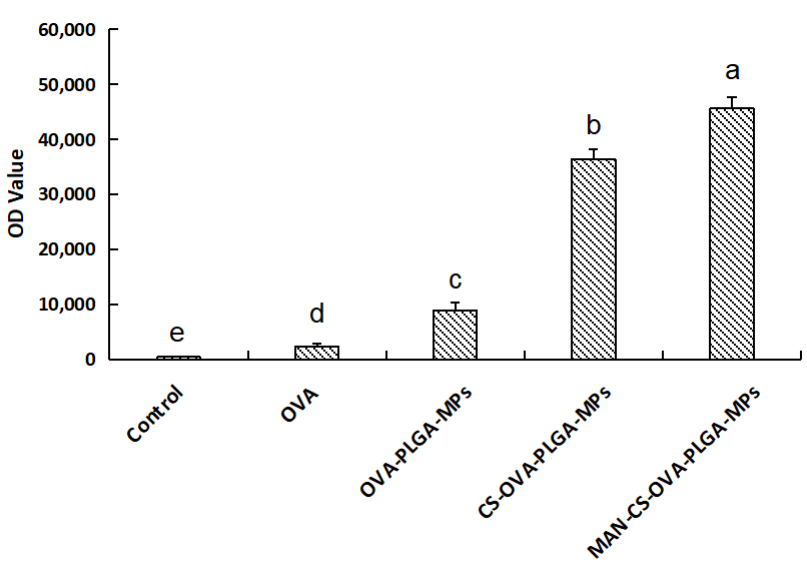
Figure 6. Effect of different microspheres on the phagocytic efficiency of DCs. Results are presented as mean ± SD ( n = 6). Bars marked with different letters ( a – e ) indicate statistically significant differences ( p < 0.05).